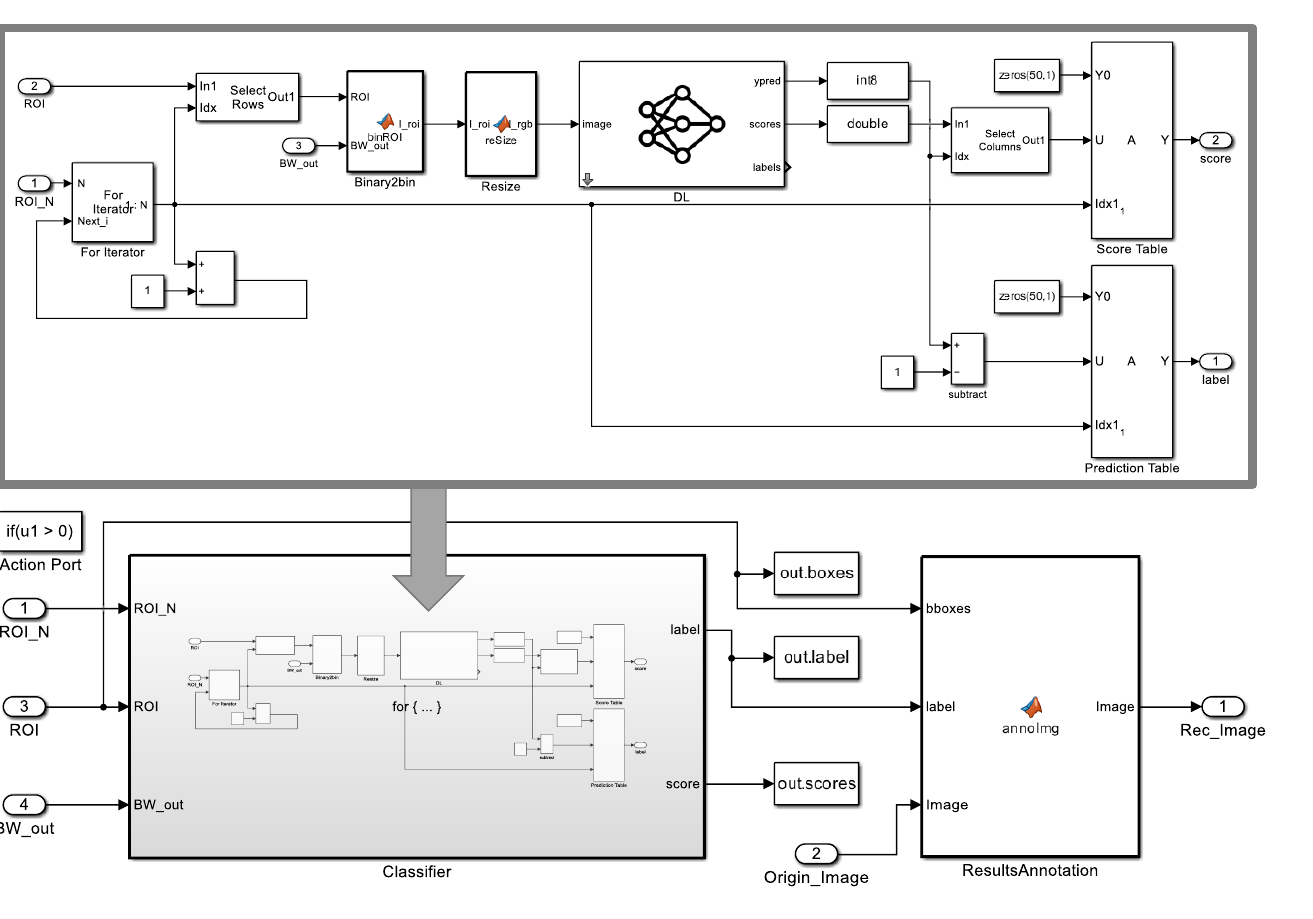
Figure 4. Classifier block in digit